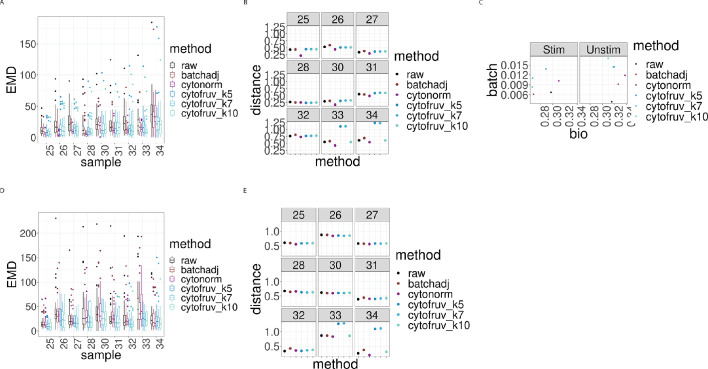
Metrics to assess the effectiveness of the normalisation methods on samples two from the CytoNorm dataset using stimulated samples two as replicated reference samples.In all panels, the colour indicates either the raw data or the method used for normalisation. (A) Boxplots of the Earth Movers Distance (EMD) between paired protein expression distributions for each batch’s stimulated sample across compared to that in the first batch. (B) Hellinger distances between paired cell subpopulation proportions for each batch’s stimulated sample compared to that in the first batch. (C) Mean Silhouette scores computed for all stimulated and unstimulated samples with those for cell subpopulations (bio) on the x-axis and for batch (batch) on the y-axis. (D) Same as (A) for the unstimulated samples. (E) Same as (B) for the unstimulated samples.